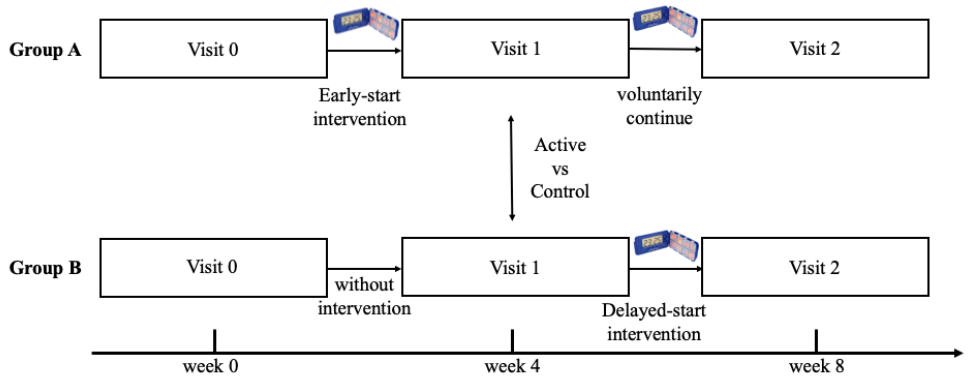
Figure 2. Graphical presentation of the protocol.